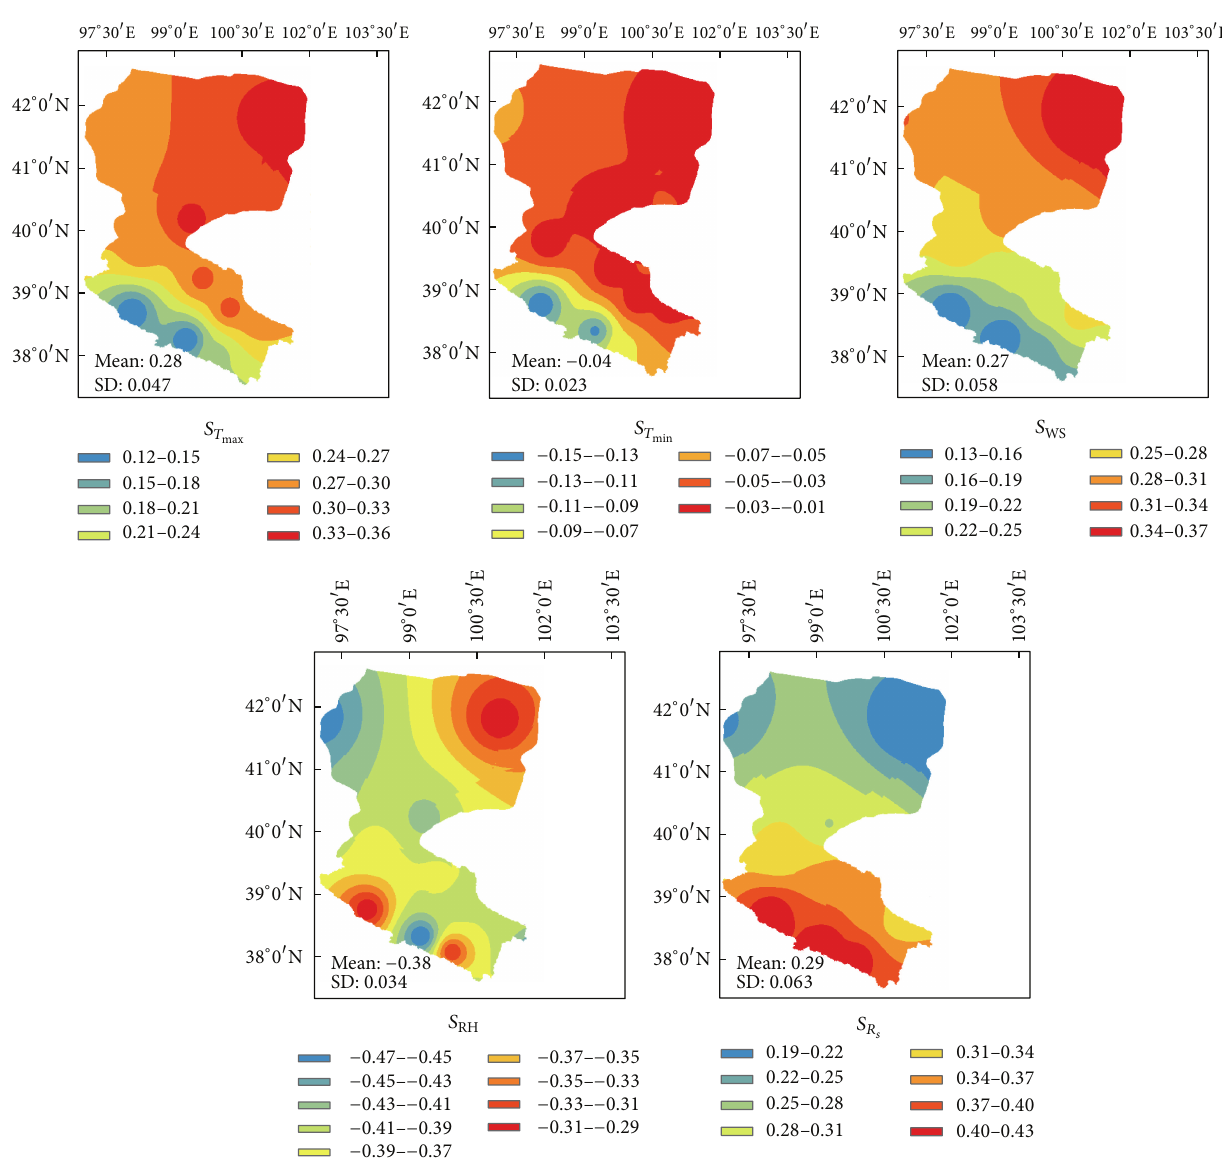
Figure 11: Spatial distribution of the mean annual sensitivity coefficients for ET 0 to the major meteorological factors ( 𝑇 max , 𝑇 min , WS, RH, and 𝑅 𝑠 ) during